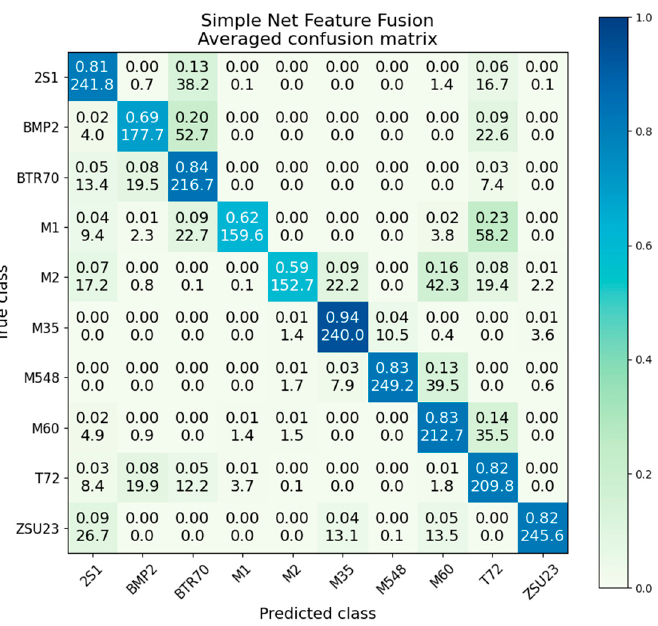
Figure 18. Averaged confusion matrix for simple net feature fusion.